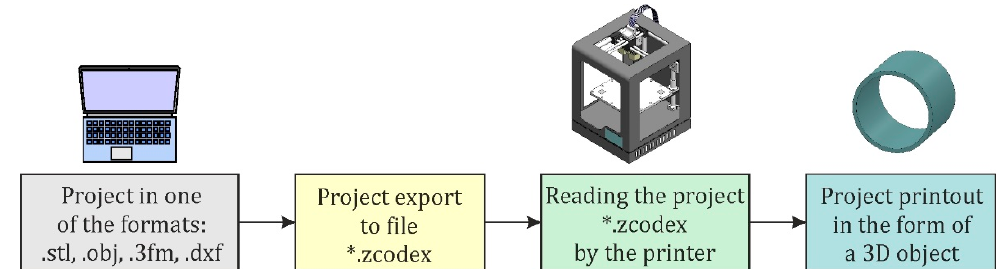
Figure 2. 3D Model of printing stages (block diagram).